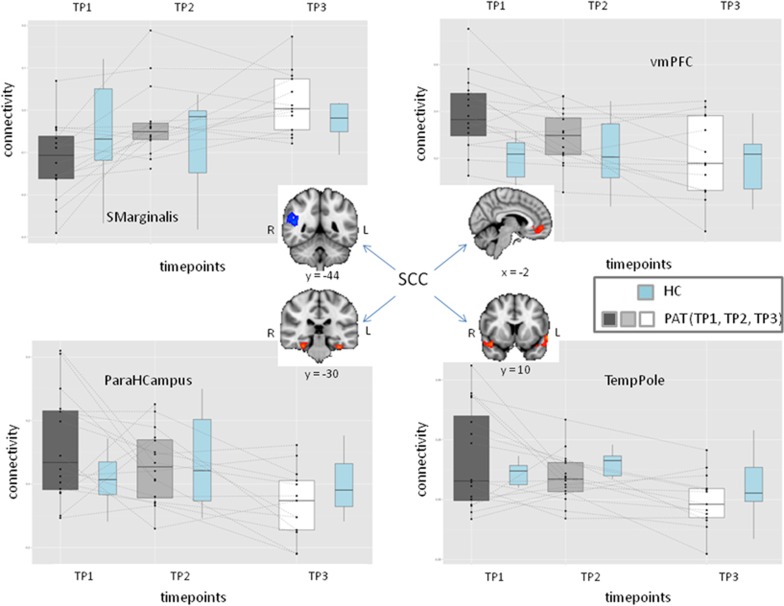
Functional connectivity of subcallosal cingulate cortex (SCC, the most significant region of the fALFF analysis) was used as a seed region to evaluate functional connectivity. Between TP1 and TP3, there were significant decreases in the correlation in three regions: ventromedial prefrontal cortex (vmPFC), bilateral parahippocampal gyrus (HCampus) and bilateral temporal pole (TempPole). We also detected increased correlations in the right supramarginal gyrus (Table 1b). Blue box plots represent normal values measured on the respective areas and time points. ECT, electroconvulsive therapy; fALFF, fractional amplitude of low frequency fluctuation; TP, time point.